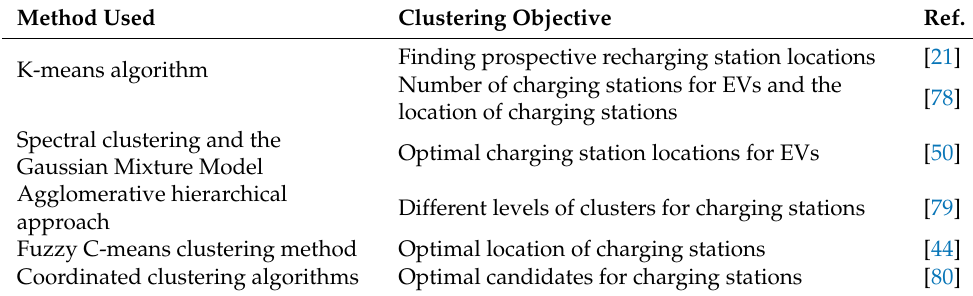
Figure 19. EV coordinated charging scheme based on charging station clustering [44]. Table 6. Summary of clustering methods along with their objectives for EV battery grouping.